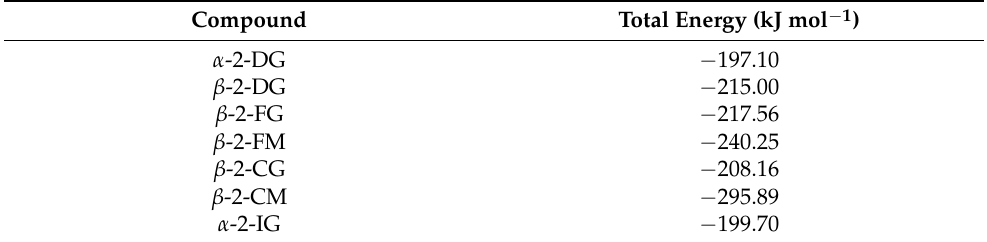
Table 1. Cohesive energies for 2-DG and its